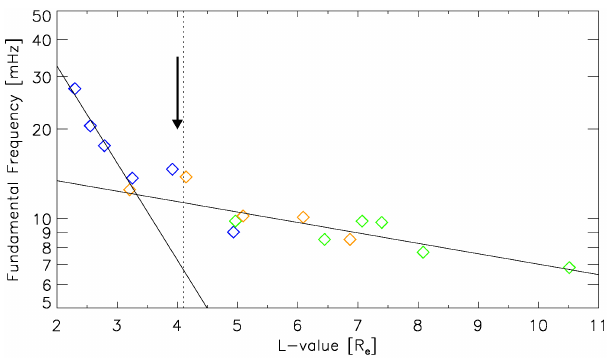
Fig. 10. Fundamental frequency over L-value. CARISMA stations are coloured green, SAMNET stations are blue and IMAGE stations are orange. The dotted vertical line indicates the position of the plasmapause predicted by Eq.